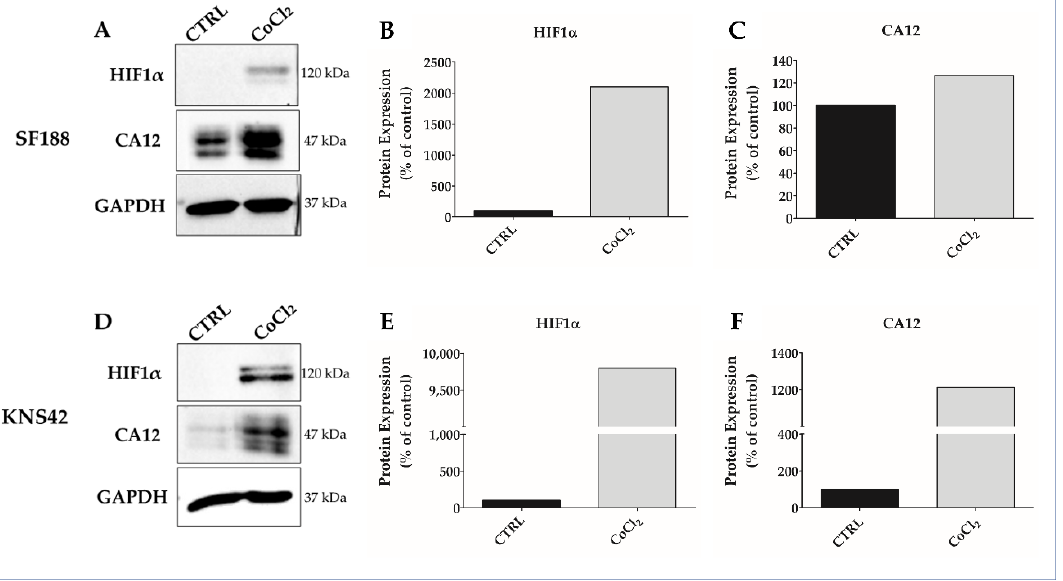
Figure 2. CoCl 2 increases protein expression of HIF1 α and CA12 in SF188 and KNS-42 pHGG cell lines. The HIF1 α and CA12 protein expression was evaluated by Western blotting in SF188 ( A ) and KNS-42 ( D ) cell lines. Graph bars indicate that the treatment for 24 h with CoCl 2 50 μ M (SF188) and 100 μ M (KNS-42) increased the expression of HIF1 α ( B and E ) and CA12 ( C and F ) compared to the control (CTRL). GAPDH was the endogenous protein used. Relative quantification of protein expression was determined using the ImageJ software.